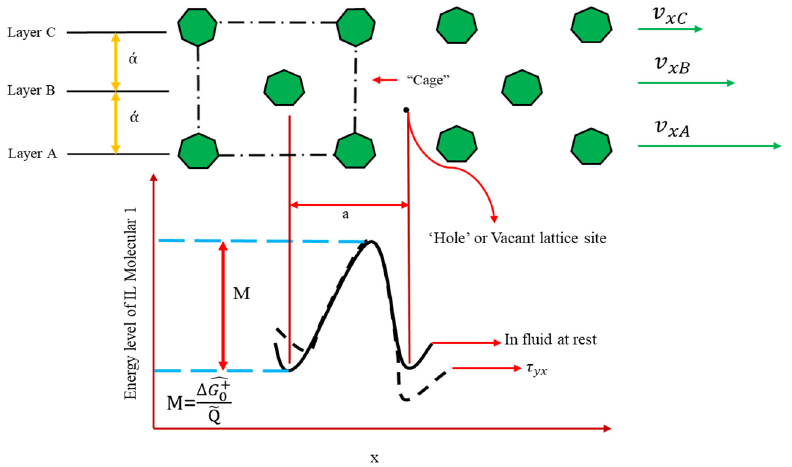
Figure 2. Illustration of an escape process in the flow of a liquid. Molecule 1 must pass through a “bottleneck” to reach the vacant site.